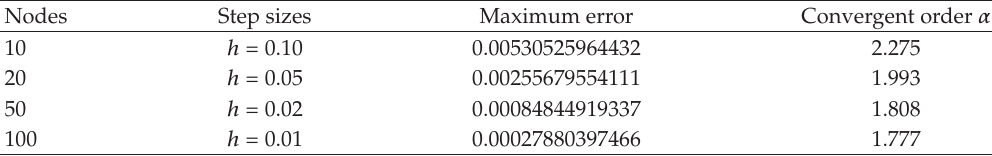
Table 2: Maximum error and convergent order of Example 4.1 with di ff erent step sizes (cid:3) computed twice via the Adams-Bashforth-Moulton method (cid:4)